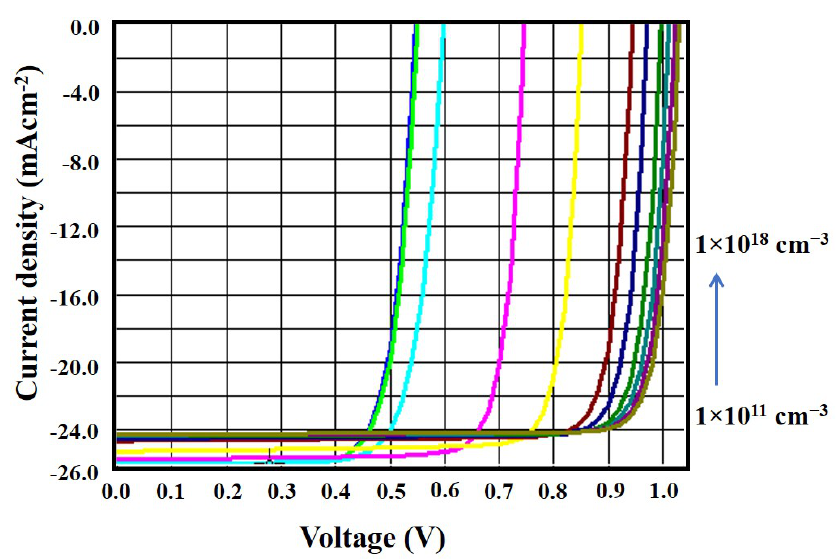
Figure 7. J–V curve with the variation of doping density in the absorber layer.